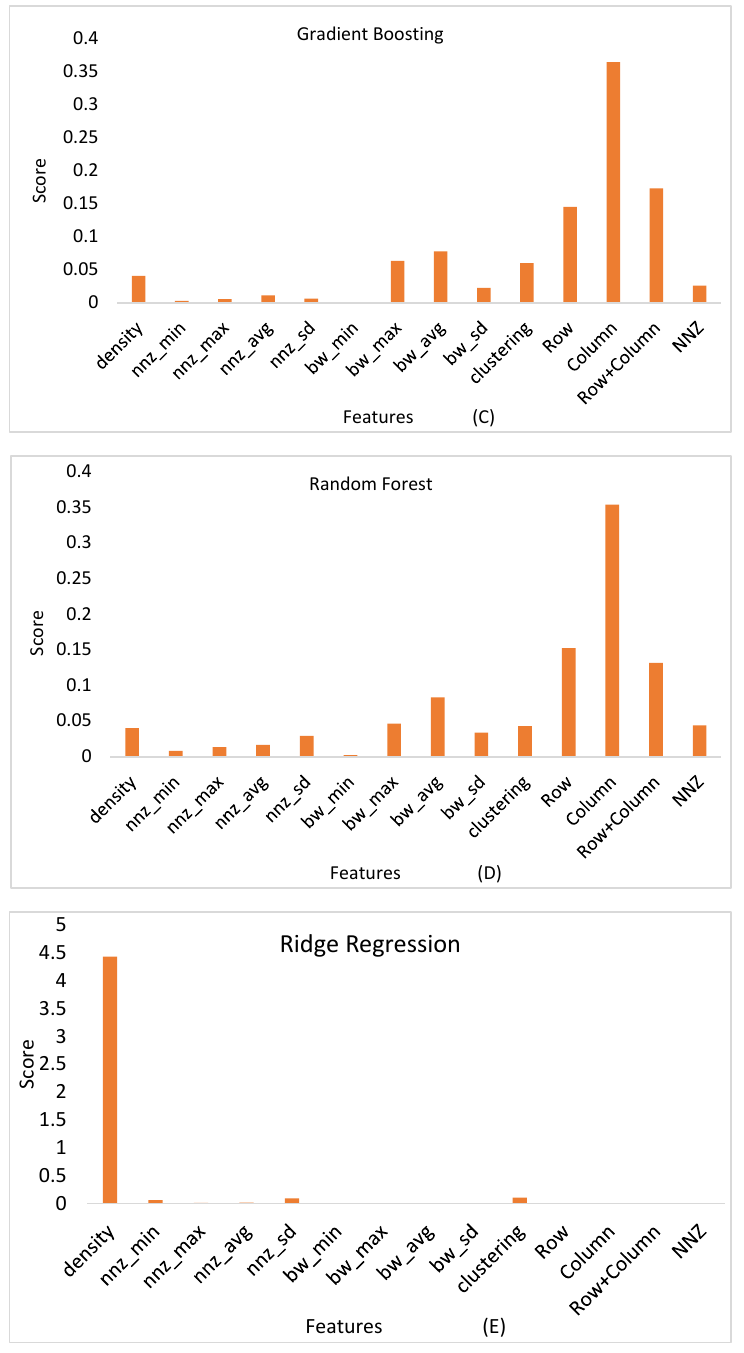
Figure 11. Feature’s score ( A ) GB, ( B ) AB, ( C ) RF, ( D ) DT, and ( E ) RR. We have drawn graphs for the actual versus predicted values (AAQAL). Actual values were obtained from the observed values in our data set. Figure 12A–E show the AAQAL versus actual observations marked as blue, while the AAQAL values are shown in